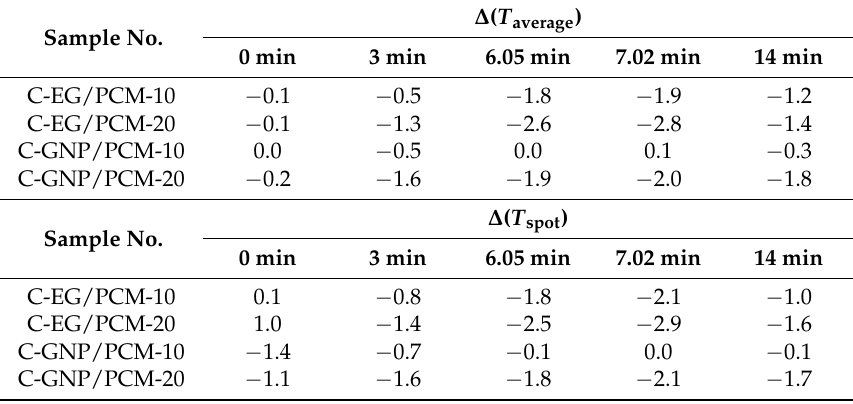
Table 4. Temperature differences between cement pastes with and without the